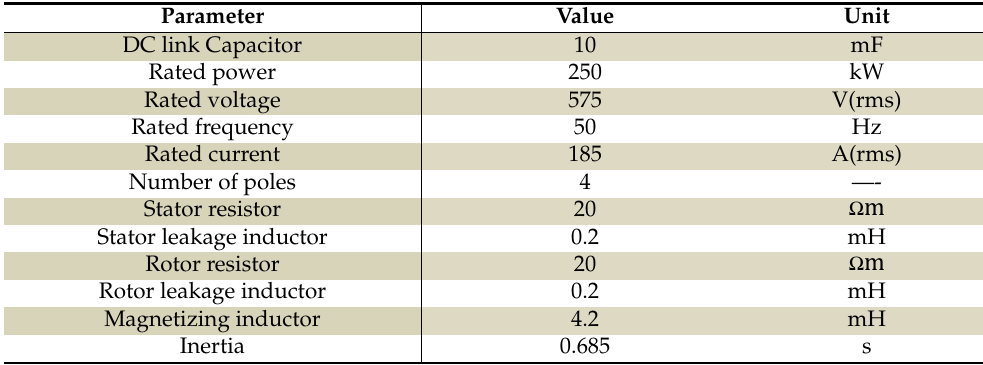
Figure 9. Overall scheme of the real-time MiL platform. Scenario I: The wind speed was 15 m/s and the drop voltage occurred in the power grid where its amplitude was half of the grid voltage. The DC-link capacitor voltage and magnitude rotor current of the DFIG system are compared with the PI controller, MINTSMC control- ler, MINTSMC controller-based DIT2-FLC in Figures 10 and 11, respectively. From Fig- ures 10 and 11, it is revealed that with the application of MINTSMC controller-based DIT2- FLC, the smallest overshoot amplitude, faster-settled behavior, and better dynamical out- comes are achieved compared to the others. Moreover, for ease of analyzing the perfor- mance and functionality of the proposed method, the grid voltage and current, along with active/reactive power and generator speed of the DFIG system are presented, as depicted in Figures 12–14 to confirm the stabilization ability of the suggested designed RSC con- troller. It can be seen from the output results that active power and reactive power reached almost 0.9 MW, 0.1 MVar, after passing the transient state, respectively. Moreover, the generator speed oscillates around 1.2 p.u.